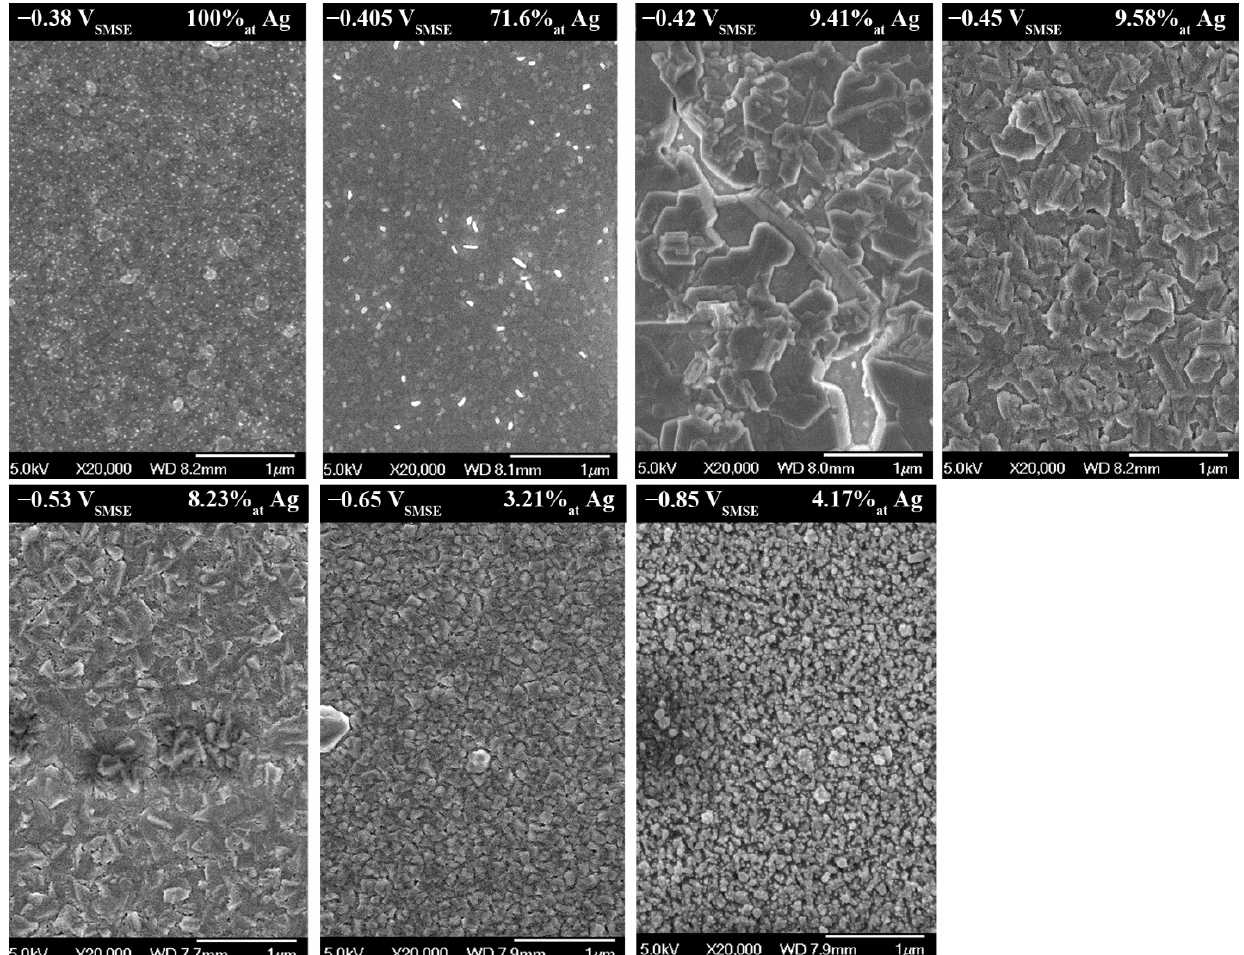
Figure 2. The SEM images of the Cu-Ag films deposited at Ru substrate at various potentials. Film thickness is ~170 nm, estimated from total charge passed during electrodeposition with 70% efficiency. Deposition bath is 0.3 M CuSO 4 + 2 mM AgNO 3 + 0.5 M H 2 SO 4 .